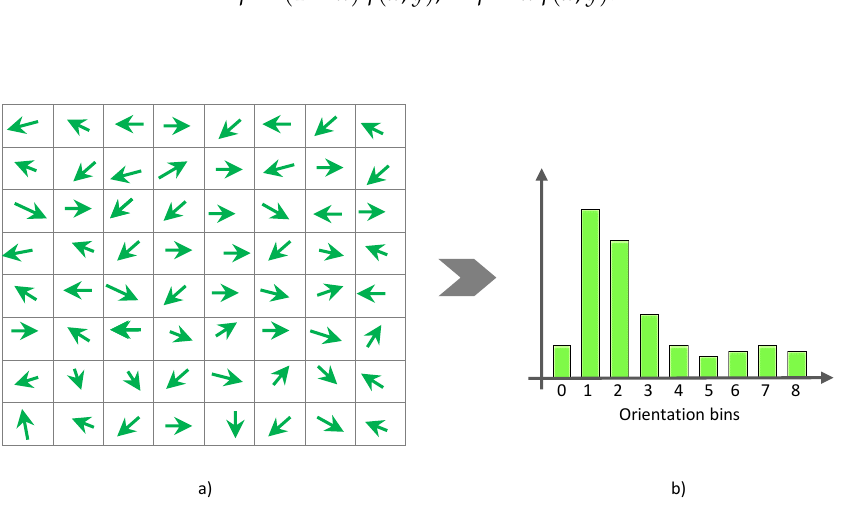
Figure 3. Gradient orientation voting: ( a ) cell gradient field; ( b ) a voting space of nine